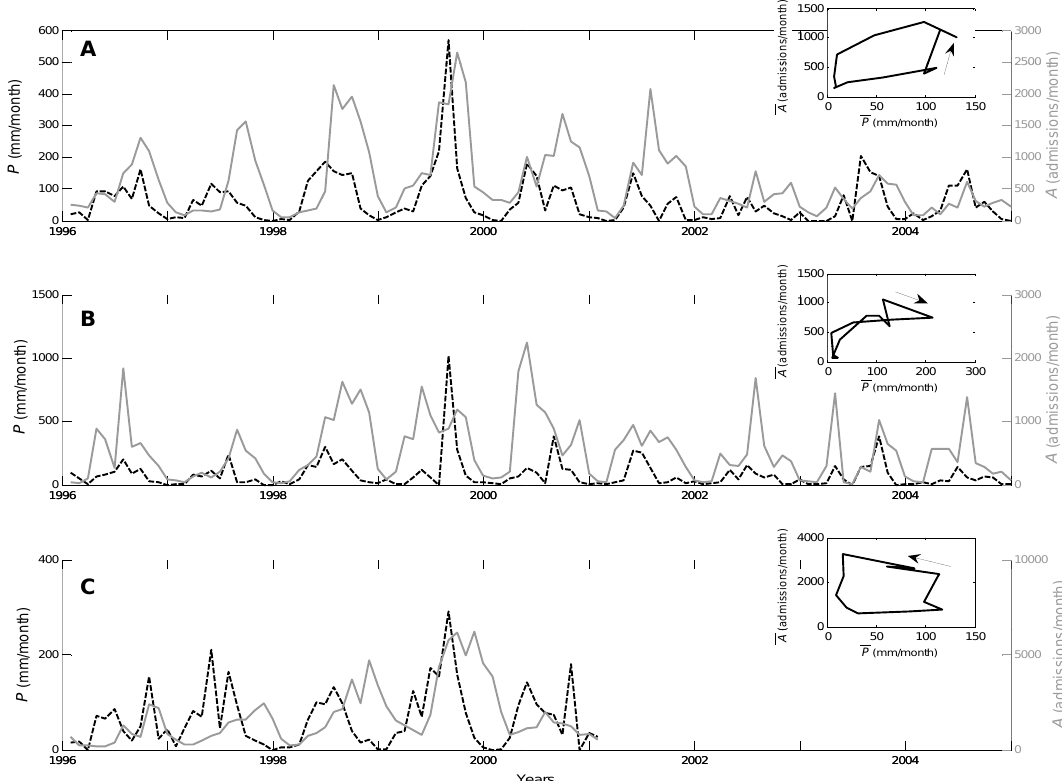
Fig. 2. Monthly malaria cases (solid grey line) and rainfall levels (dashed black line) for (A) Mpumalanga, (B) Limpopo, and (C) KwaZulu- Natal provinces. Insets describe seasonal averages of malaria cases and rainfall rates (time proceeds according to the